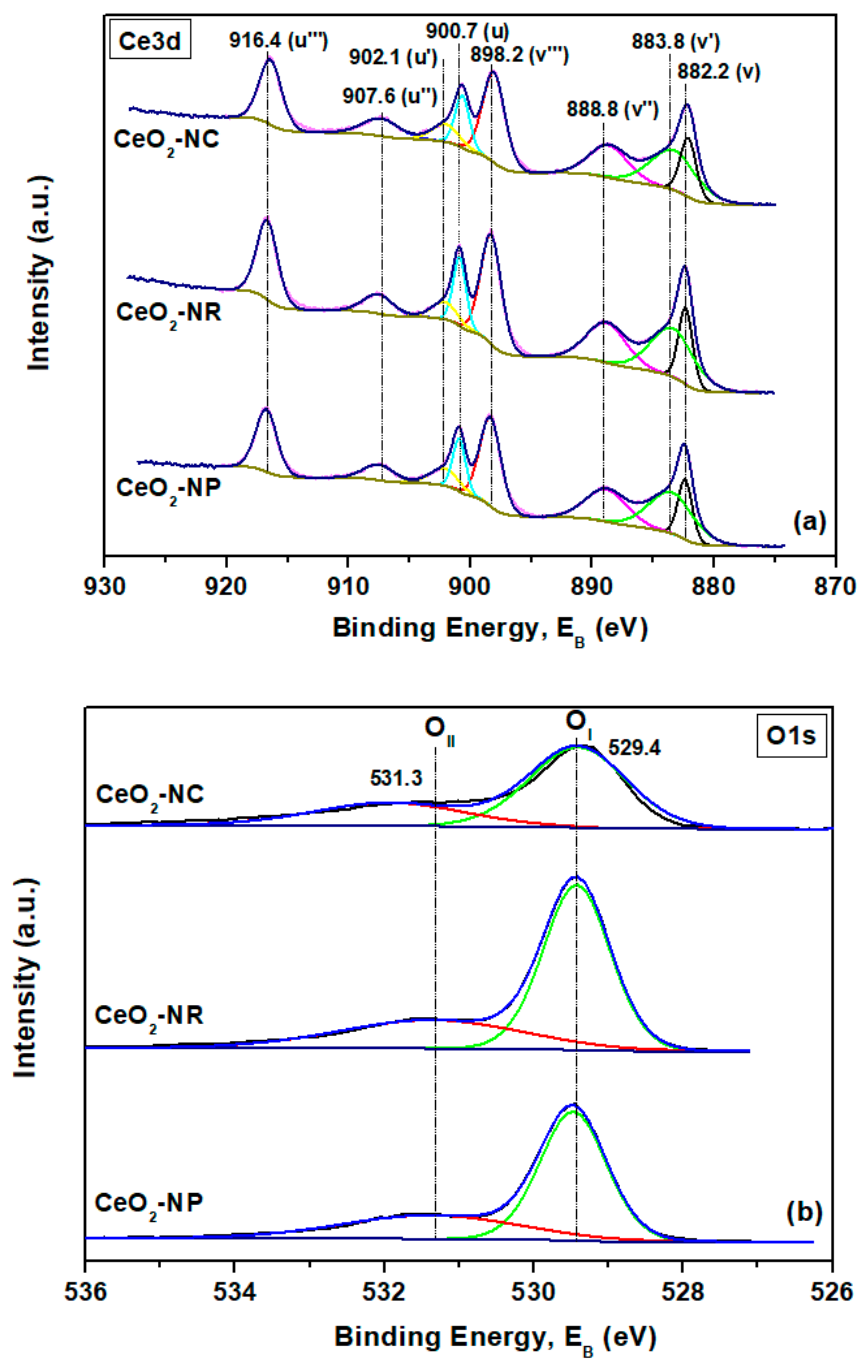
Figure 6. Ce 3d (a) and O 1s (b) XPS spectra of ceria nanoparticles. Figure 6. Ce 3d ( a ) and O 1s ( b ) XPS spectra of ceria